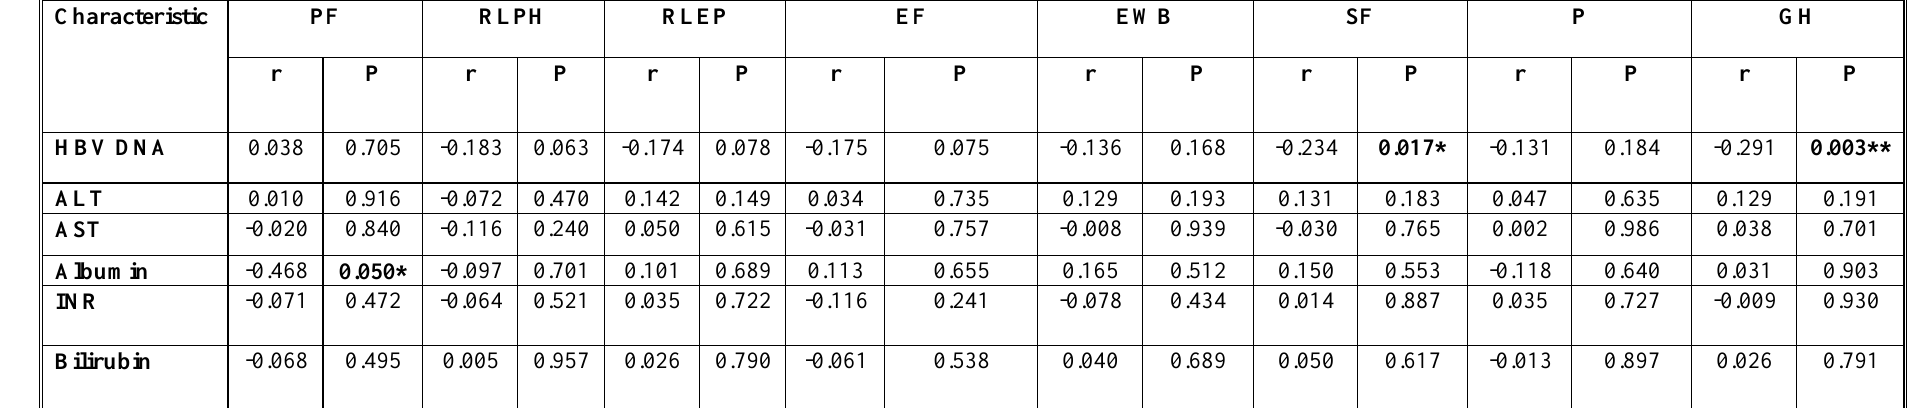
Table 6. Correlations between short form domain scores and laboratory investigations patients with chronic hepatitis B